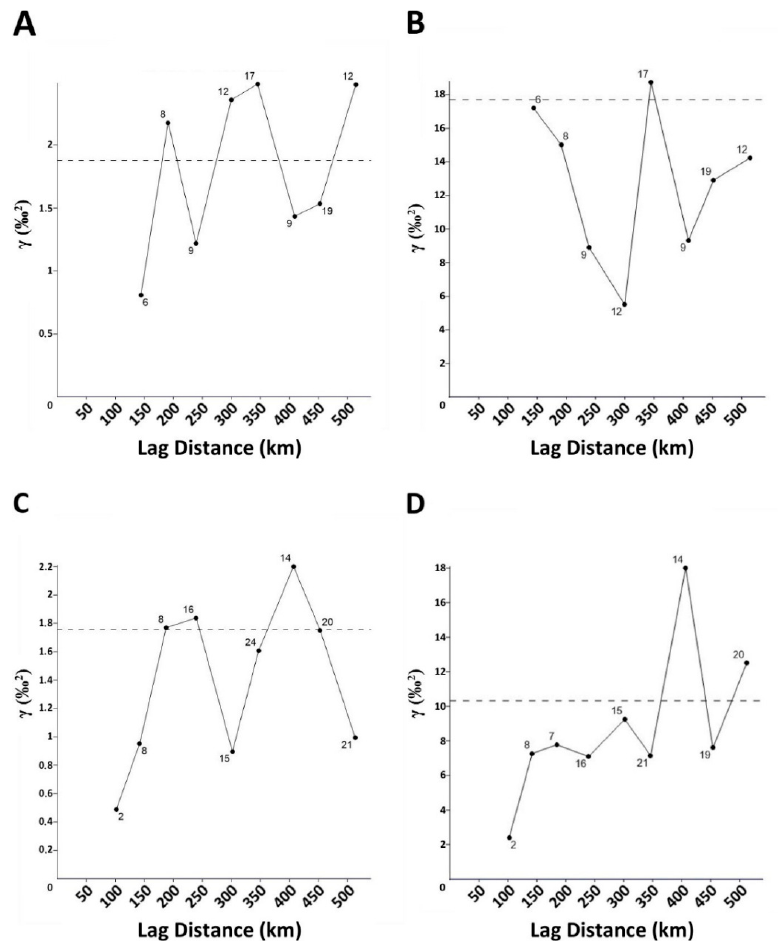
Figure 4. Empirical semivariograms of δ 18 O p and d-excess for March 2003 ( A , B , respectively) and December 2002 ( C , D , respectively). The semivariograms from the March data are of the nugget-type, while the December ones have a rising section. The numbers next to the empirical semivariogram (black dots) show the data pairs within a given distance (bin width was 54 km) behind the semivariograms. The dashed line indicates the average variance.